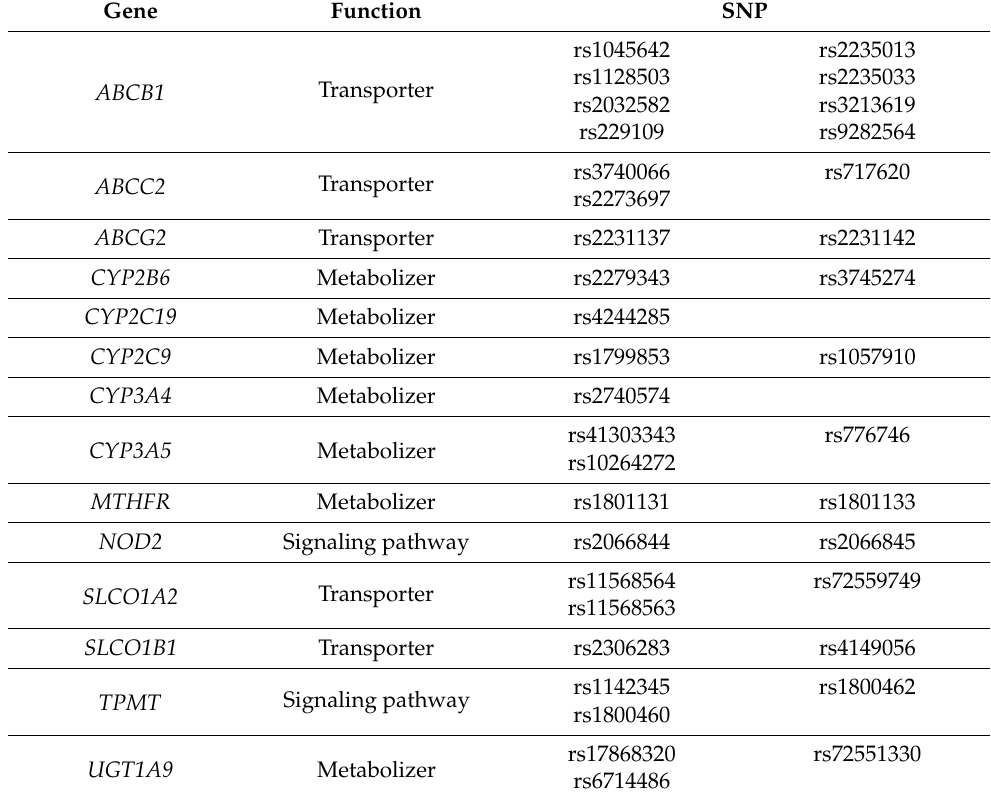
Table 2. SNPs included within the pharmacogenetics